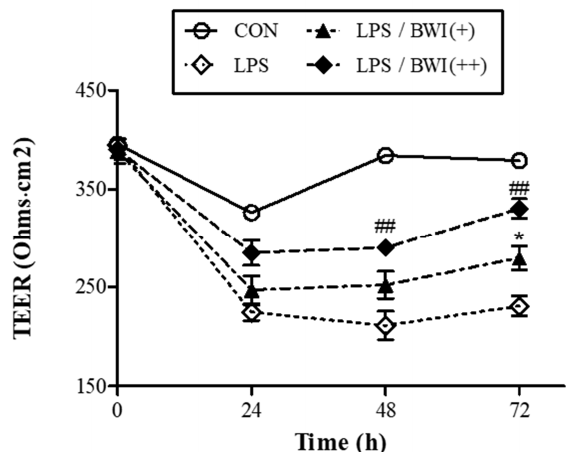
Figure 4. BWI mediated-increase in barrier integrity measured by TEER in the co-culture model system. By measuring TEER, the integrity of intestinal barrier function was observed for a given time course. The co-culture model system applied in previous experiments was used to monitor the TEER value. The LPS (1 ug/mL) and two doses of BWI mix (“+” and “++” were 1 × 10 6 and 1 × 10 7 cells/mL respectively) were applied to the experiments. ### p < 0.001 vs. control; * p < 0.05 vs. LPS.